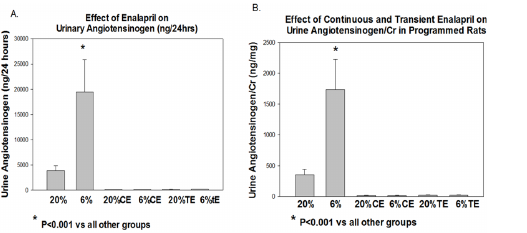
Fig 2. Effect of continuous and transient enalapril on urine angiotensinogen levels in control and programmed rats. Rats from the 6 groups were placed in metabolic cages at 6 months of age. 24 hour total urine angiotensinogen (A) and urinary angiotensinogen/creatinine (Cr) levels (B) were measured in control and prenatal programmed rats. Urine angiotensinogen /24 hours and urinary angiotensinogen/cr were higher in the offspring of the 6% rats compared to all other groups. N = 11 – 16 in each